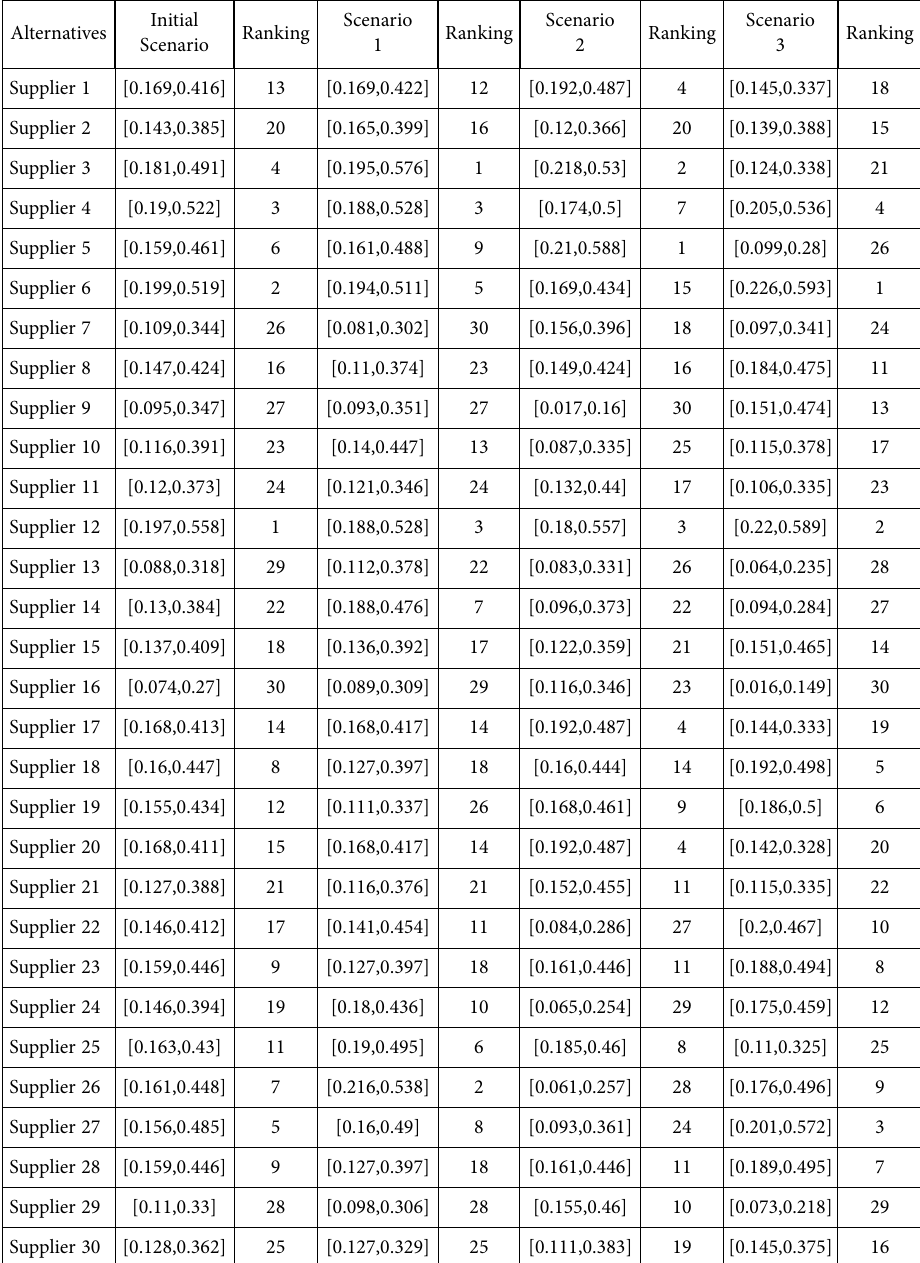
Table 11. Results of the sensitivity